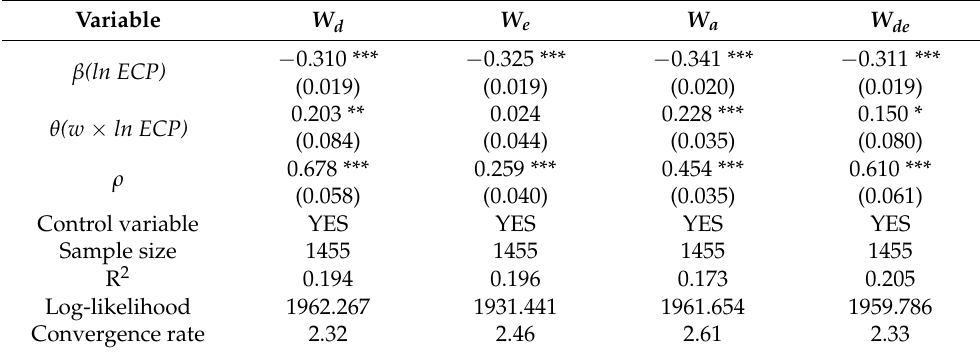
Table 4. Estimated results of the global spatial convergence model for ECP in the